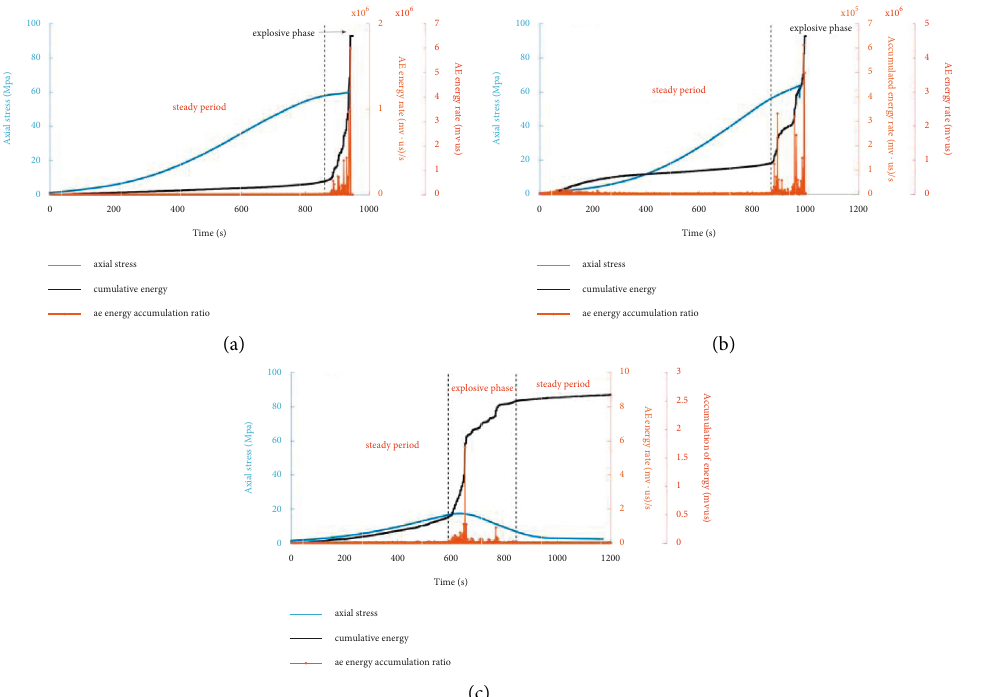
Figure 16: AE energy rate, cumulative energy and stress-time curve of green sandstone. (a) 20 cycles. (b) 30 cycles. (c) 40